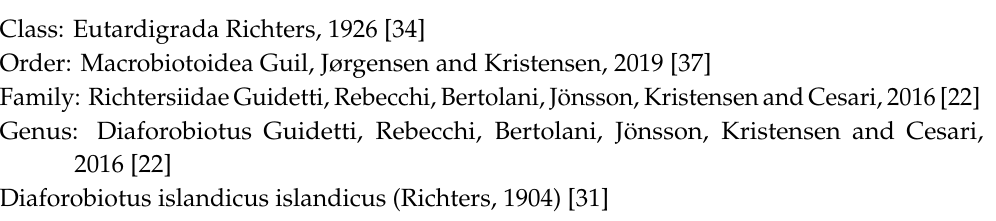
Figure 1. Echiniscus granulatus : ( A ) Habitus, ( B ) dorsal plates, ( C ) detail of the cuticular ornamentation, ( D ) claws of the fourth pair of legs; using phase contrast microscopy.